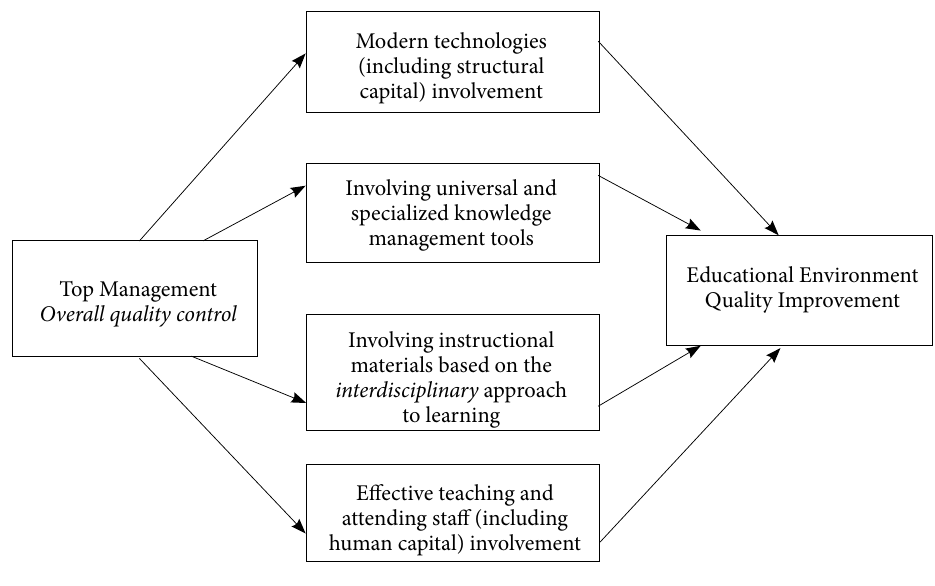
Fig. 1. EE Quality improvement